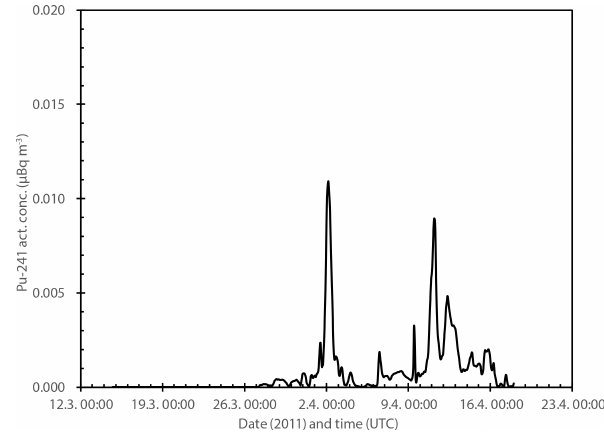
Figure 9. Modeled hourly 241 Pu activity concentration (µBqm − 3 ) in the surface air of Rovaniemi in March–April